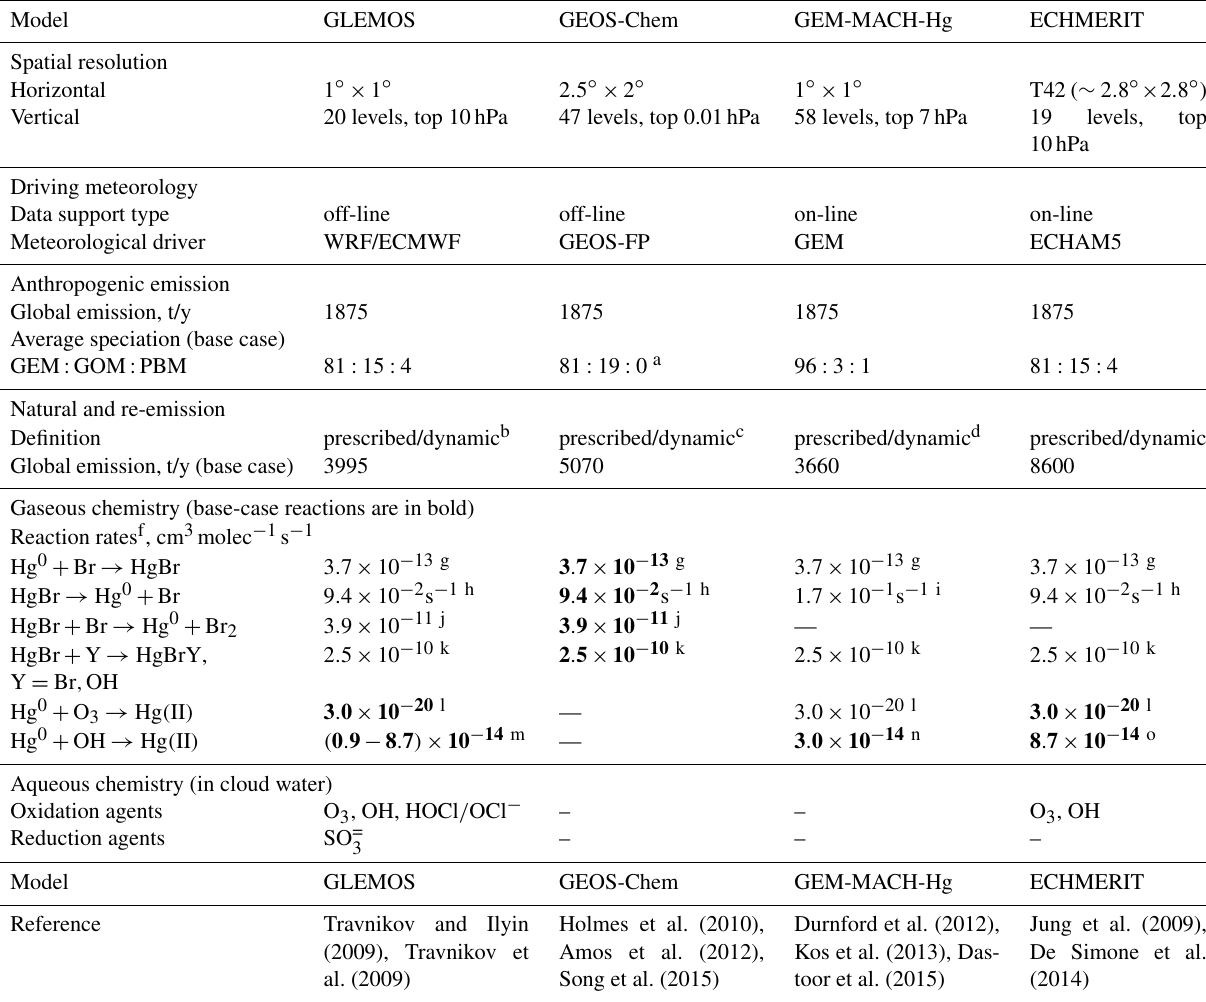
Table 1. Characteristics of the participating global chemistry transport models.